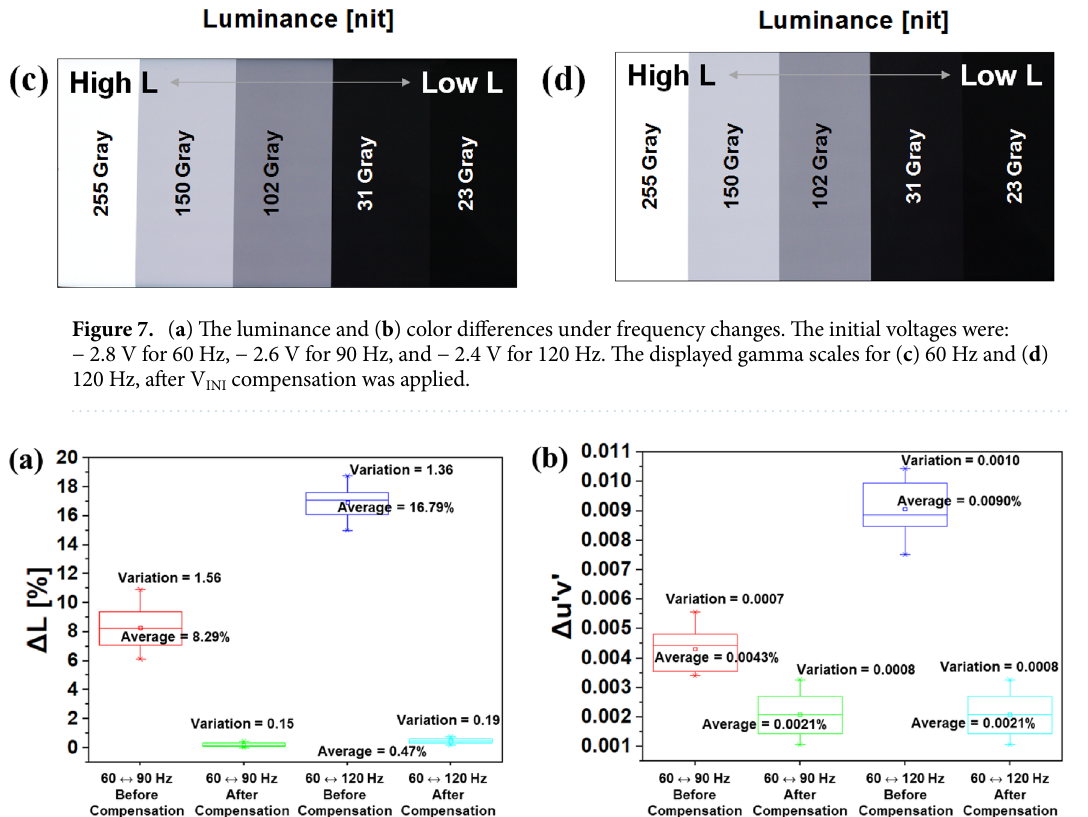
Figure 8. Box plot data for ( a ) luminance and ( b ) color differences showing their variation before and after the initial voltage compensation evaluated with 10 samples